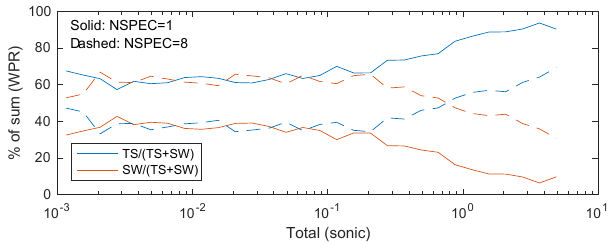
Figure 12. Mean percent contribution of the WPR time series (TS; blue) and spectral width (SW; red) variances to the sum of the TS and SW variances binned by the total variance of the sonic anemometers. Solid lines use NSPEC = 1 and dashed lines use NSPEC = 8 from the 449MHz WPR at four overlapping heights.